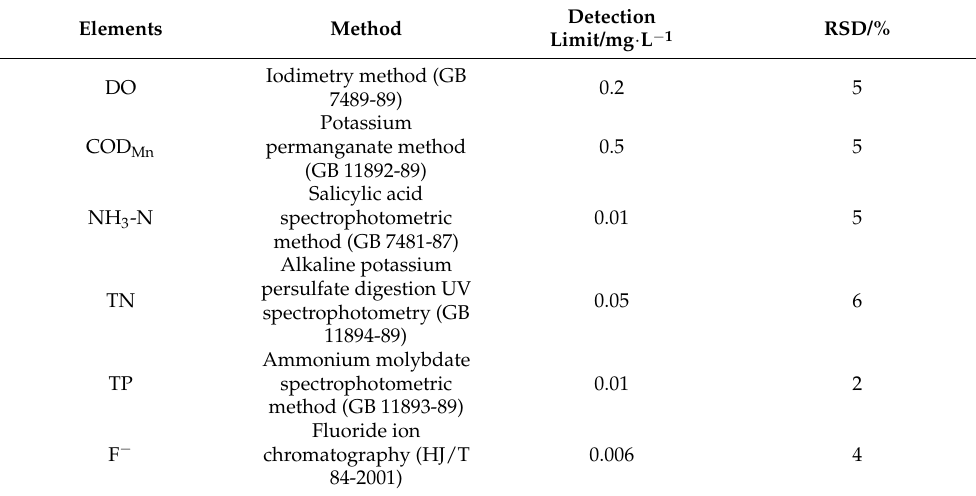
Table 2. Detection methods, detection limits, and relative standard deviations of water quality